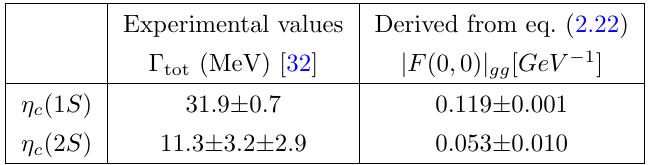
Table 1 . Total decay widths as well as j F (0 ; 0) j obtained from (cid:0) tot using the next-to-leading order approximation (see eq. (2.22)). Derived from eq. (2.21)